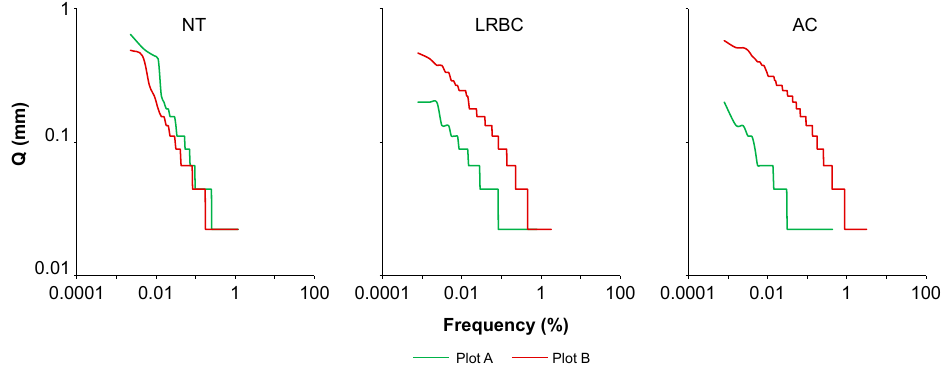
Besides runoff, the runoff frequency represented by the ratio of runoff frequency in plot B to runoff frequency in plot A ( T B/A ) also increased with disturbance: 0.977, 2.292, and 7.250 in the NT, LRBC, and AC phases, respectively (Table 1). In the NT phase, surface runoff frequency was slightly higher in plot A as visualised in the flow-duration curve (FDC) in Figure 7. In the LRBC and AC phases, despite a decrease in surface runoff frequency in plot A, surface runoff frequency in plot B have increased. The FDC of plot B also became more convex, which is a sign of increased frequency of high-magnitude surface runoff.